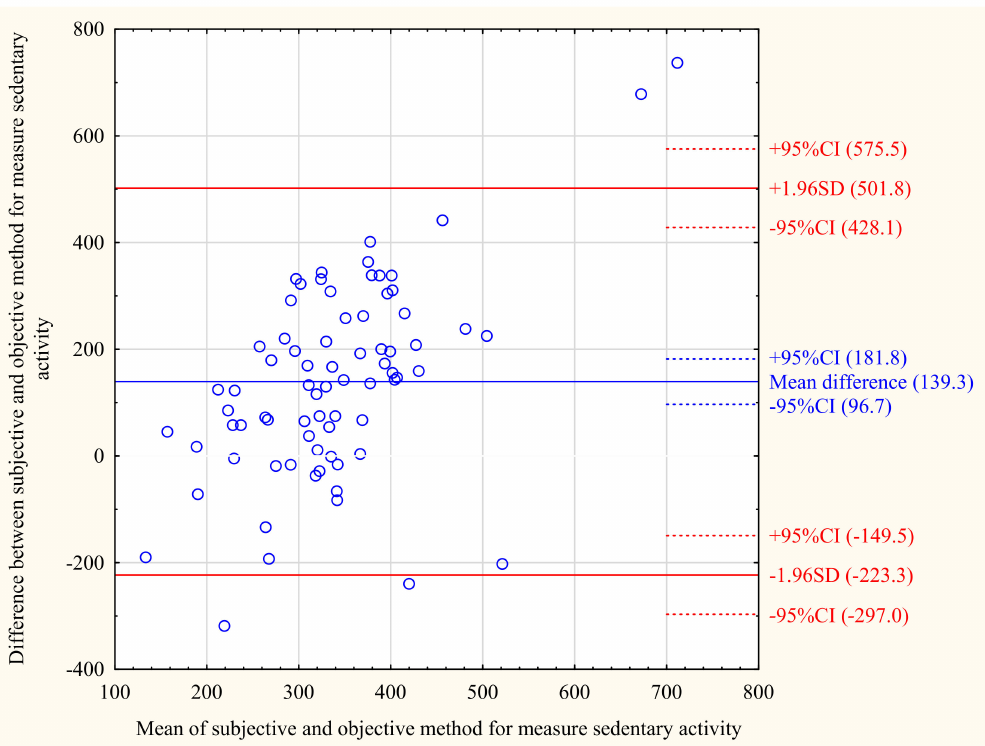
Figure 1. Bland–Altman plot for sedentary behaviour [min/day] measured by the IPAQ and ActiGraph in total study population ( n = 75).